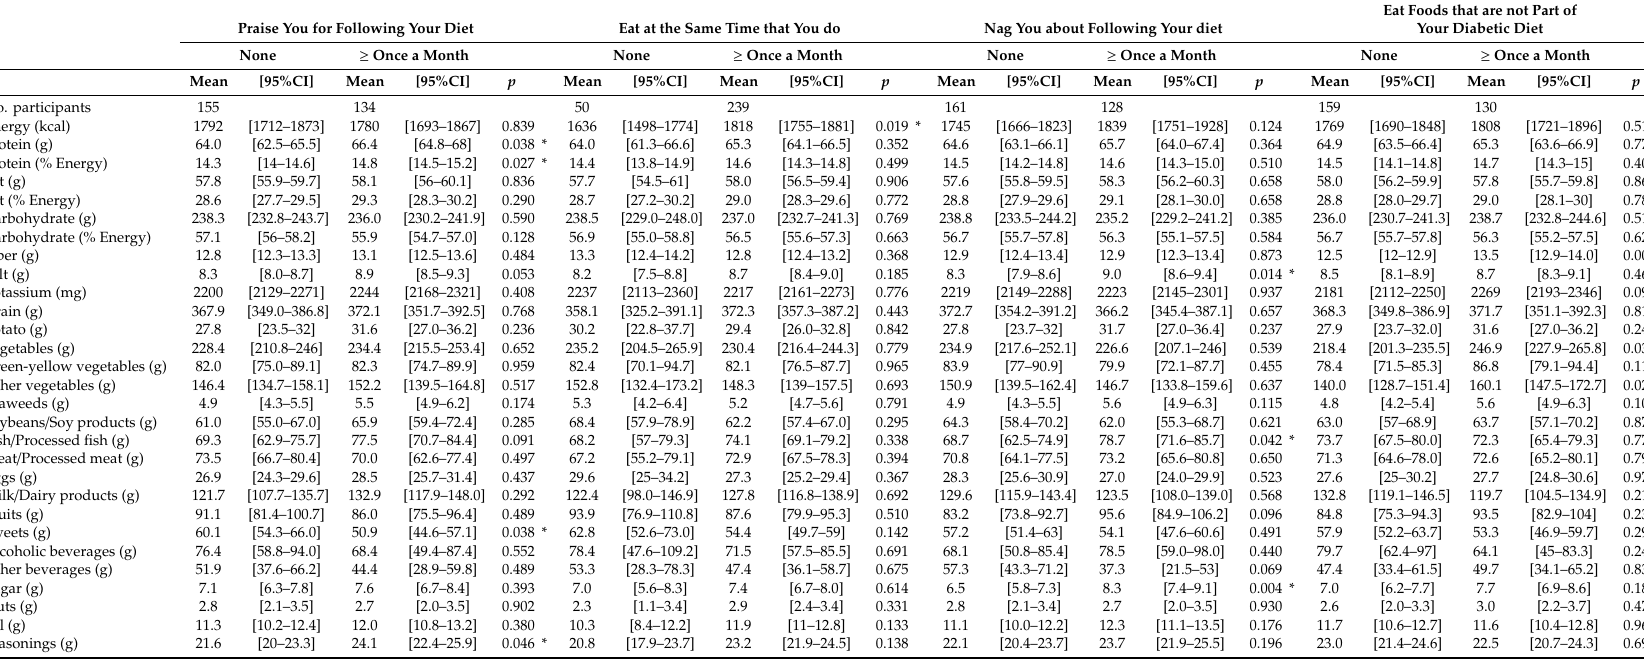
Table 2. Dietary intake and response to the Diabetes Family Behavior Checklist (DFBC) scale for MNT in patients with type 2 diabetes ( N =